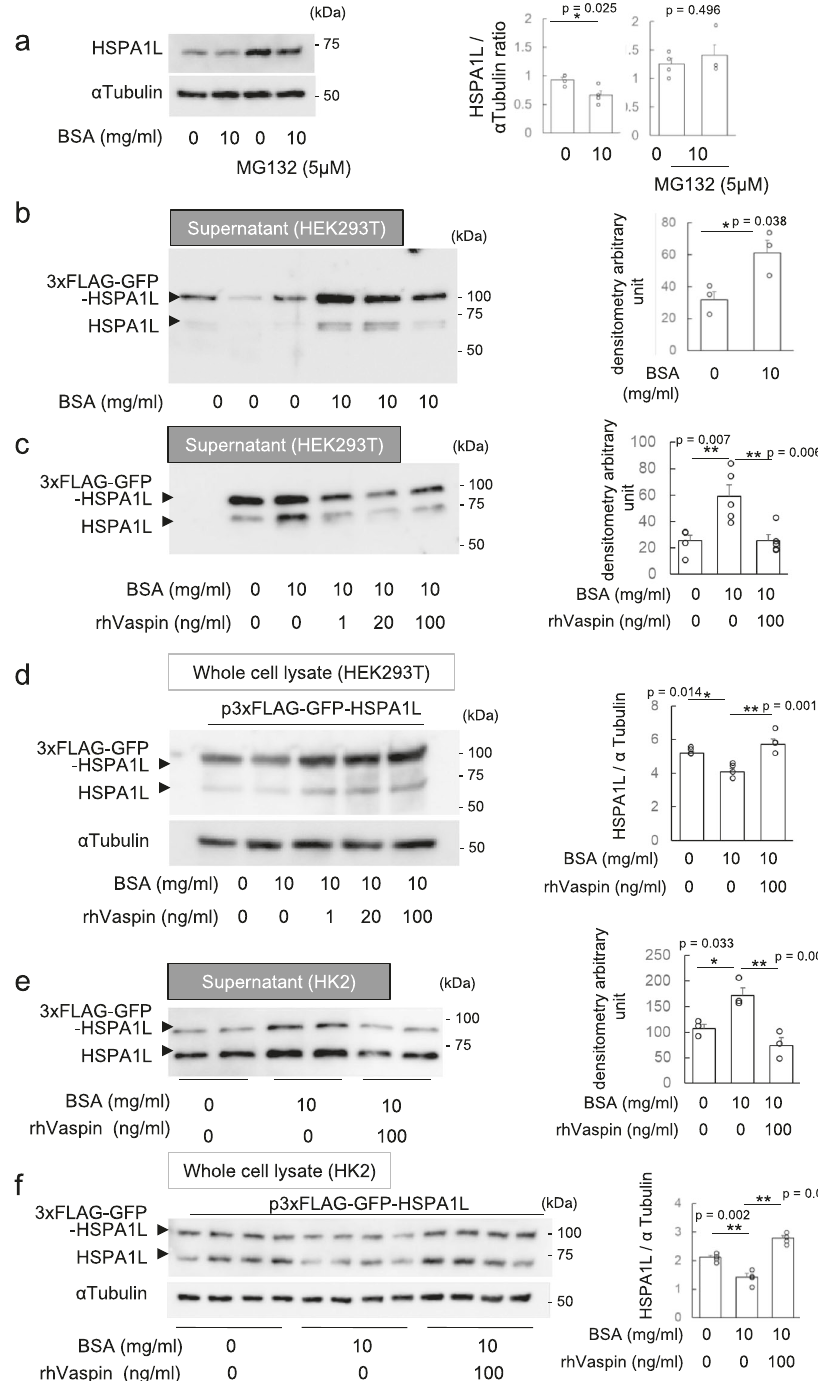
Fig. 7 Inhibition of BSA-induced HSPA1L secretion by rhVaspin. a HK2 cells were cultured with BSA 0 or 10 mg/ml at the presence of MG132 0 or 5 μ M for 10 hr. BSA-induced decrease of HSPA1L protein levels was partially reversed by MG132. b HEK293T cells expressing p3xFLAG-GFP-HSPA1L were cultured with BSA at 0 or 10 mg/ml. Supernatant of HEK293T cell were immunoprecipitated with ANTI-FLAG M2 af fi nity agarose gel. Secreted HSPA1L was detected by Western blot analysis using anti-HSPA1L antibody. c HEK293T cells expressing p3xFLAG-GFP-HSPA1L were cultured with BSA at a dose of 0 or 10 mg/ml for 24 h. In addition to BSA, rhVaspin was administrated at a dose of 0, 1, 20, 100 ng/ml. Supernatant of HEK293T cell were immunoprecipitated with ANTI-FLAG M2 af fi nity agarose gel. Secreted HSPA1L was detected by Western blot analysis using anti-HSPA1L antibody. d Whole cell lysates were subjected to Western blot analyses. Blotting was performed by HSPA1L and normalized by α Tubulin. e HK2 cells expressing p3xFLAG-GFP-HSPA1L were cultured with BSA at a dose of 0 or 10 mg/ml for 24 hr. rhVaspin was co-cultured at a dose of 100 ng/ml. Supernatants of HK2 cell were immunoprecipitated with ANTI-FLAG M2 af fi nity agarose gel. Secreted HSPA1L was detected by Western blot analysis using anti-HSPA1L antibody. f Whole cell lysates were subjected to Western blot analyses. Blotting was performed by HSPA1L and total densitometry quanti fi cation of HSPA1L and 3xFLAG-GFP-HSPA1L are normalized by α Tubulin. Right panel shows statistical analysis. Data are shown as means ± S.E. N = 4 ( a ), 3 ( b ), 5 ( c ), 4 ( d ), 3 ( e ), 4 and ( f ), * p < 0.05, ** p < 0.01. Western blots were repeated twice. COMMUNICATIONS BIOLOGY| (2021) 4:373 |https://doi.org/10.1038/s42003-021-01902-y|www.nature.com/commsbio